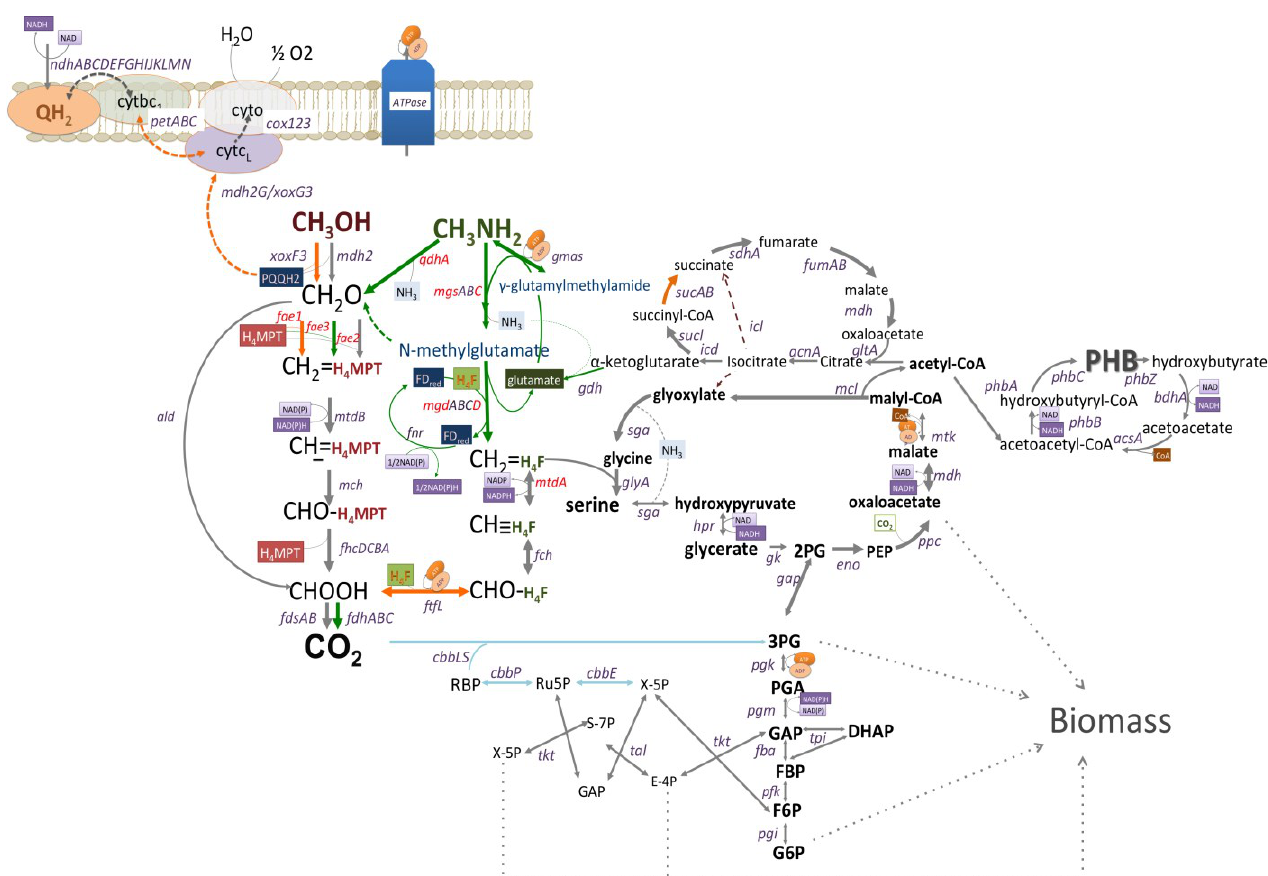
Figure 1. The reconstructed pathway of methanol and methylamine utilization in Methyloversaltilis universalis FAM5 based on genomic, transcriptomic and mutagenesis data. Genes mutated in this study are shown in red. Pathways upregulated (6–11 fold) by growth on methylamine are shown in green; Pathways slightly downregulated (1.5–3 fold) by growth on methylamine are shown in orange; Grey lines show pathways whose expression do not change; and Blue lines indicate steps that are not expressed on tested C1-compounds, methanol or